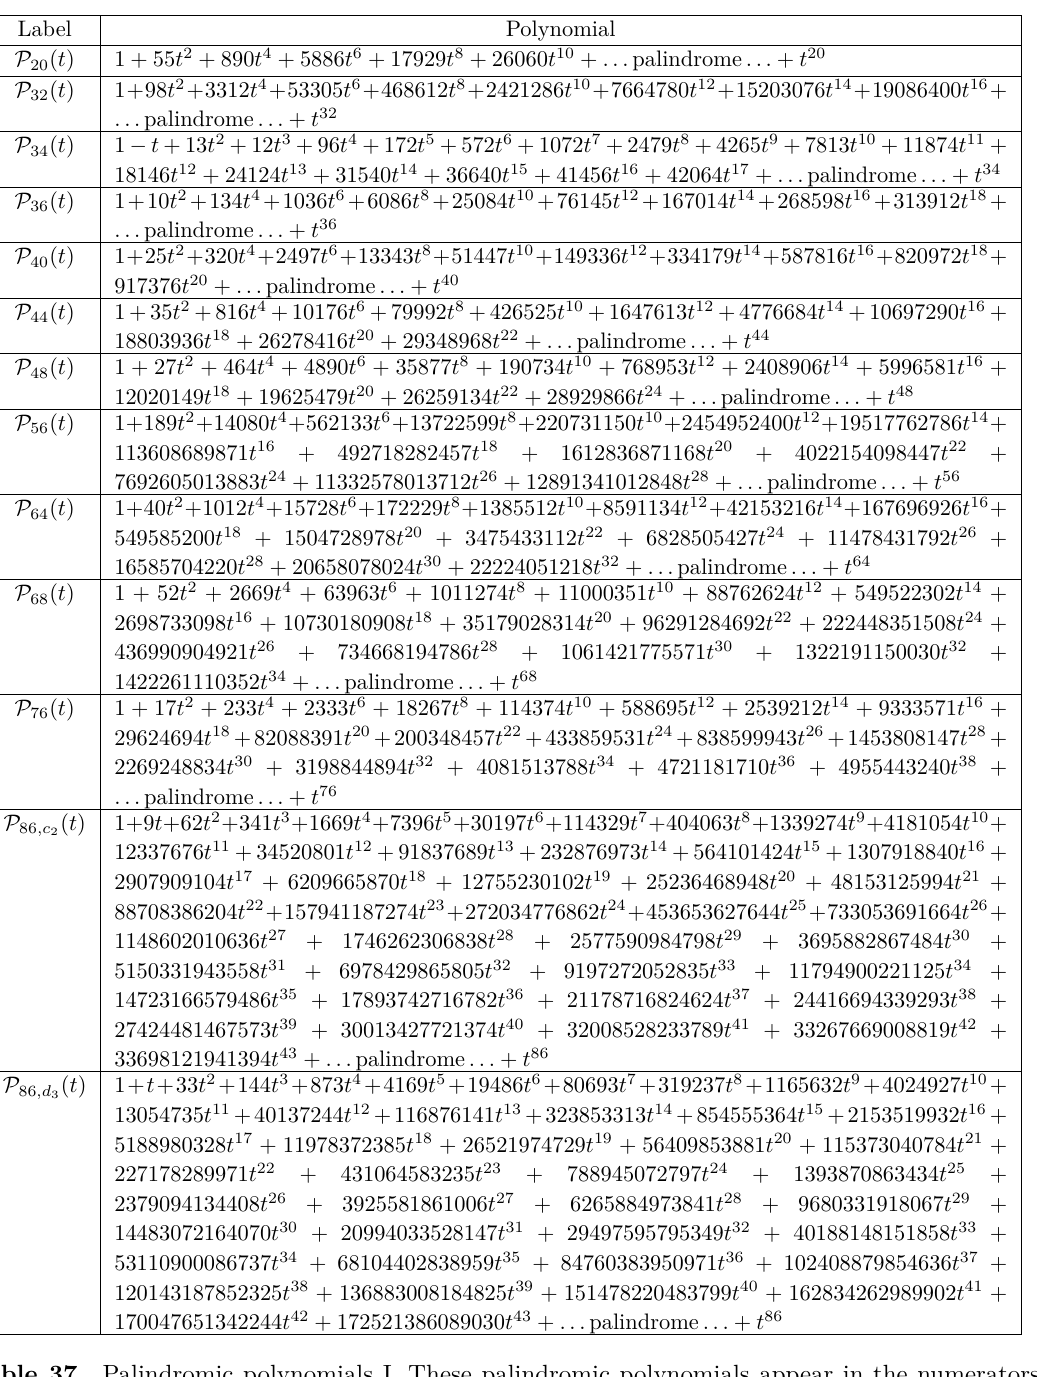
Table 37. Palindromic polynomials I. These palindromic polynomials appear in the numerators of Hilbert series. They are identified by the degree of the fugacity t , augmented by further labels as